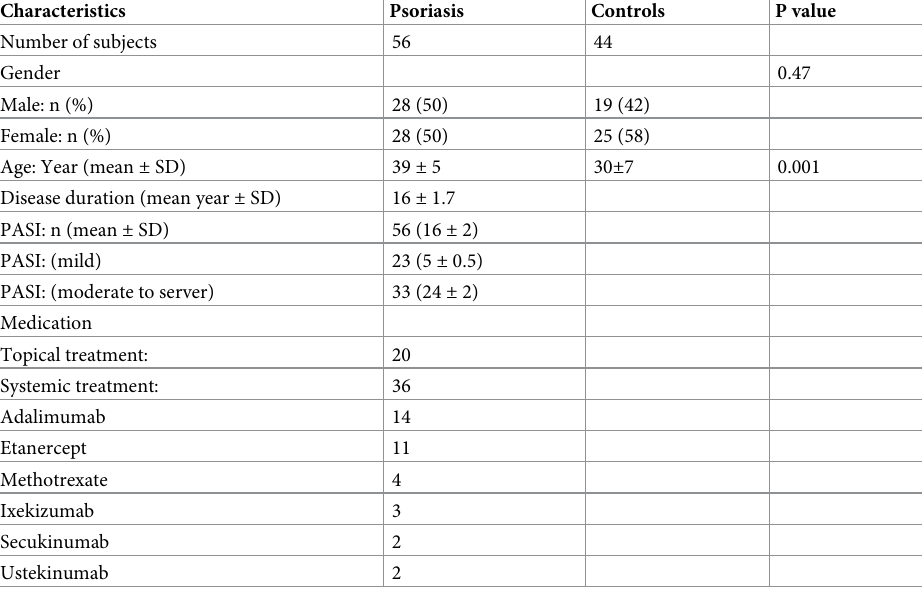
Table 1. Demographics and clinical characteristics of psoriasis patients and healthy controls.